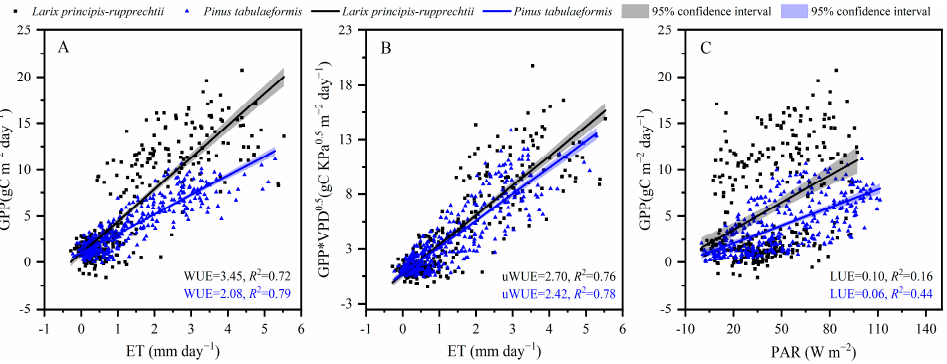
Figure 6. The regression relationship between GPP, GPP × VPD 0.5 , and ET, and between GPP and PAR in two forest ecosystems. Based on Equations (7)–(9), slopes in the figure represent the water